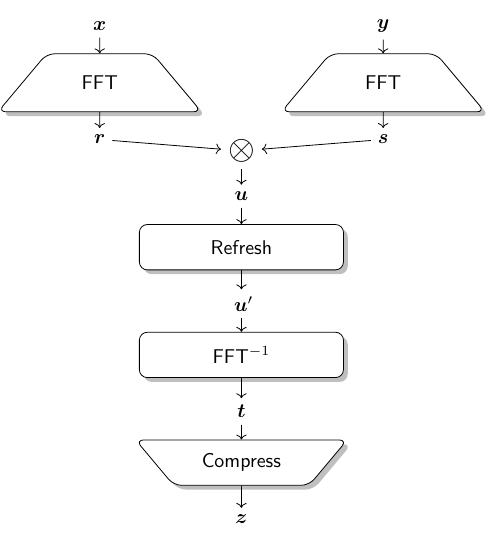
Figure 4: Multiplication